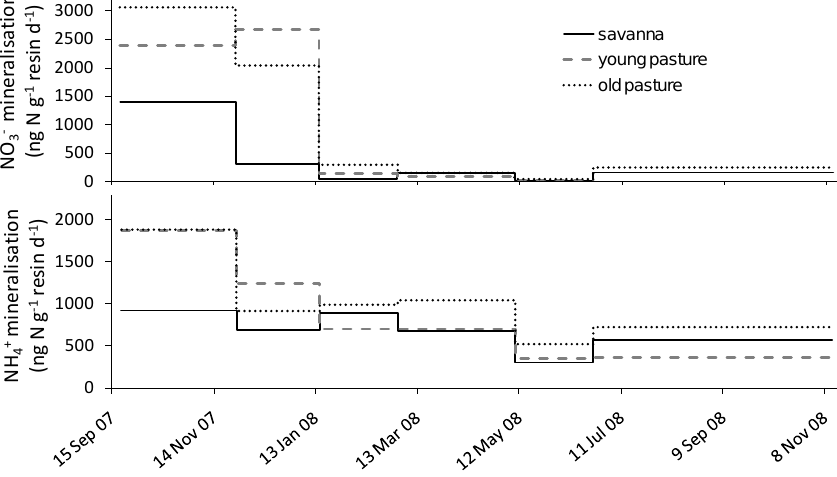
Fig. 3. Net nitrate and ammonia mineralisation rates as measured with shallow buried ( ∼ 5cm) resin bags in savanna woodland, young pasture and old pasture sites. Means are from three replicate sites for each land use. At each site three resin bags were buried.